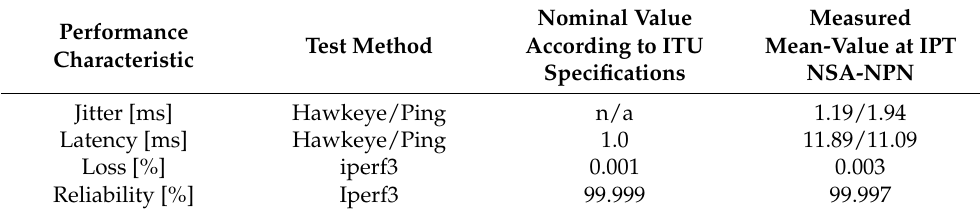
Table 4. Summary of measured 5G-NSA-NPN values and comparison to nominal values.